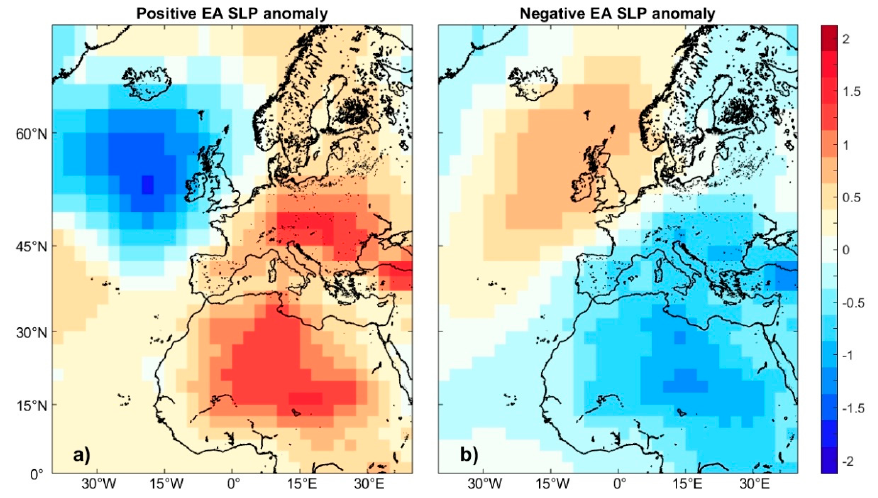
Figure 3. Composites of sea level pressure anomalies (mbar) in the period 1948–2008. Panel ( a ) reflects the positive phase (higher quartile) and panel ( b ) the negative phase (lower quartile) of the EA.